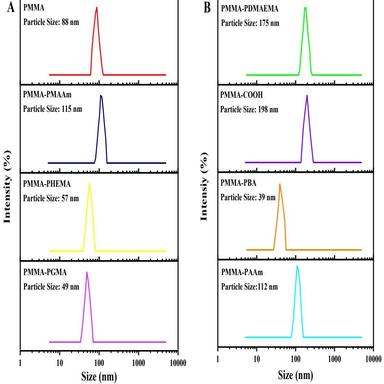
DLS curves of multi-functionalized polymer nanoparticles prepared by Emulsion copolymerization.